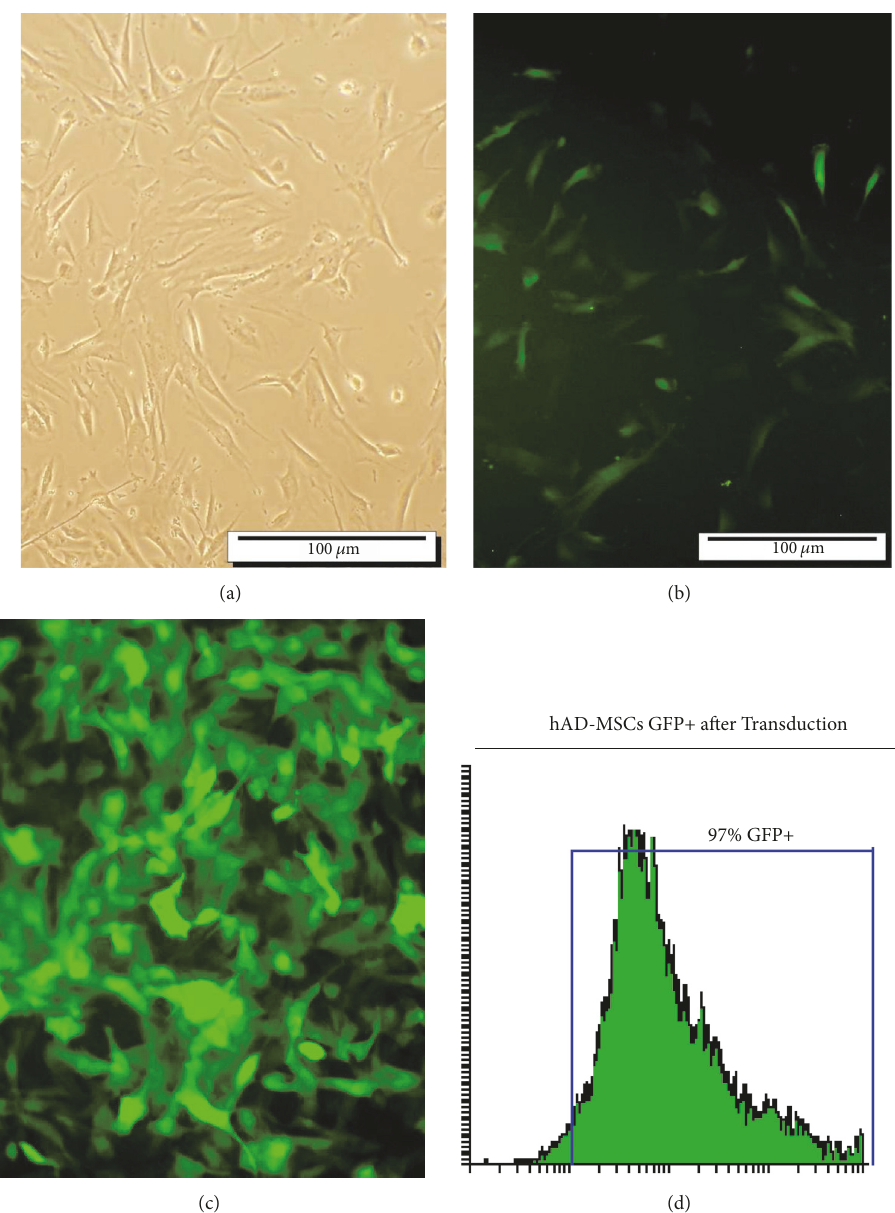
Figure 4: Adipocyte-derived mesenchymal stem cells (hAD-MSCs) transduction with lentiviral particles. (a) hAD-MSCs before transduction. (b) hAD-MSCs transduced with pCDH-RIL-23R-PGK-copGFP lentiviral vector. (c) Transduced hAD-MSCs after puromycin selection;abundant green cells and GFP expression exhibit high transduction level (d) FACS analysis of the transduction rateafter puromycin selection indicated that more than 90% of the cells were GFP